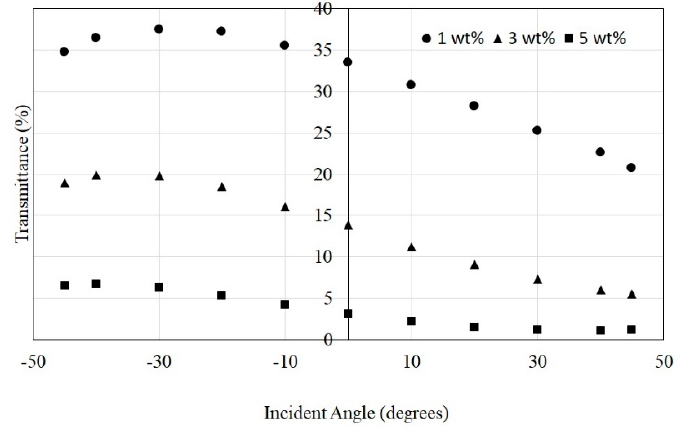
Figure 7. Transmittance dependences of the incident angles for the two-layer HAN-LCDs, as shown in Figure 4, using LC materials containing 1, 3, and 5 wt.% of dichroic dye, NKX-4173 (Hayashibara Ltd., Japan).